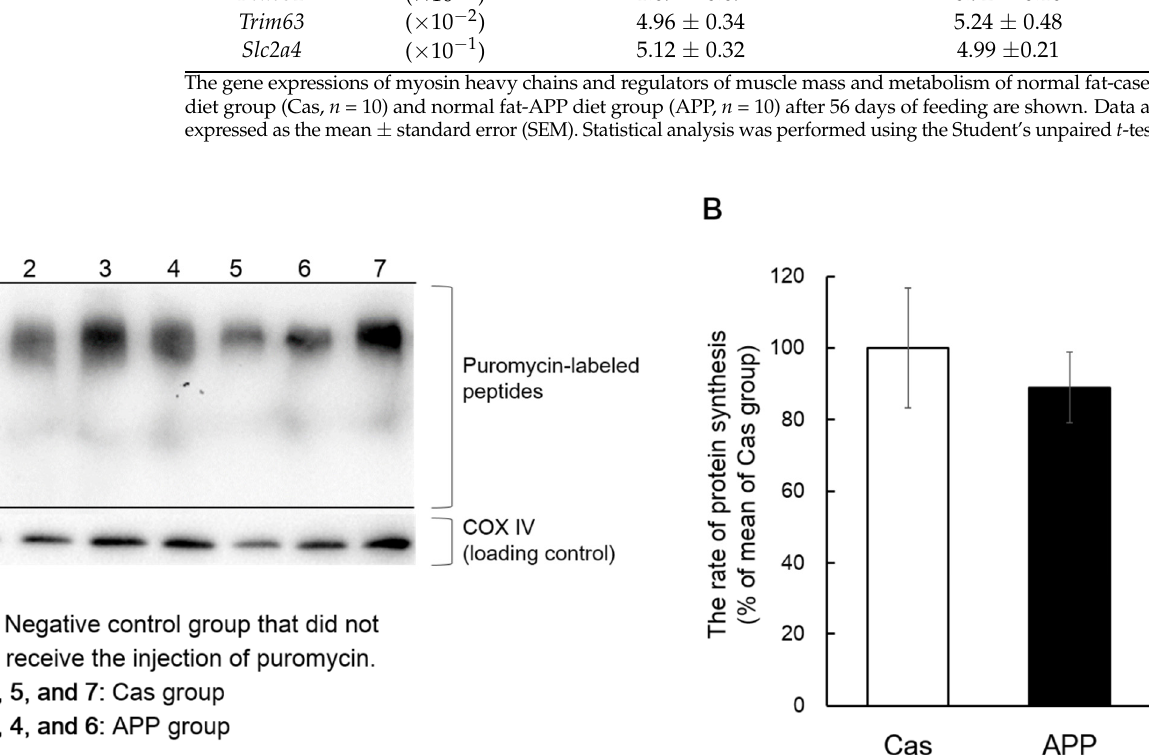
The gene expressions of myosin heavy chains and regulators of muscle mass and metabolism of normal fat-casein diet group (Cas, n = 10) and normal fat-APP diet group (APP, n = 10) after 56 days of feeding are shown. Data are expressed as the mean ± standard error (SEM). Statistical analysis was performed using the Student’s unpaired t-test.